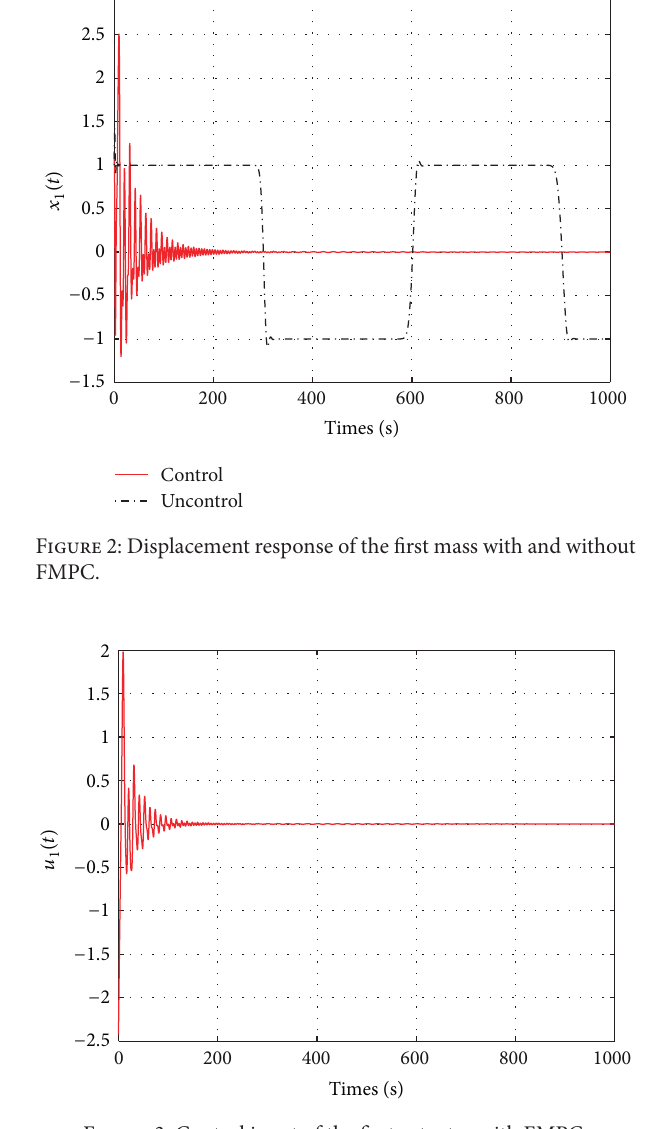
Figure 3: Control input of the first actuator with